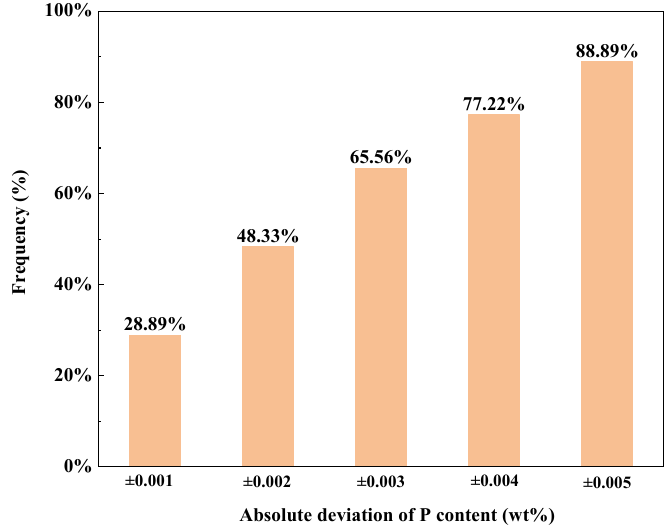
Figure 5. Frequency of absolute deviation of P content in the prediction model. The points between the dotted lines indicate that the errors are within ±0.004 (wt%). Most of the predicted data shown in Figure 4 is concentrated within the error range of ±0.004 (wt%). However, compared to the range of variation from actual value, the margin of relative error is still colossal. Results of the prediction model indicate there is still a gap between the predicted value and the actual result.